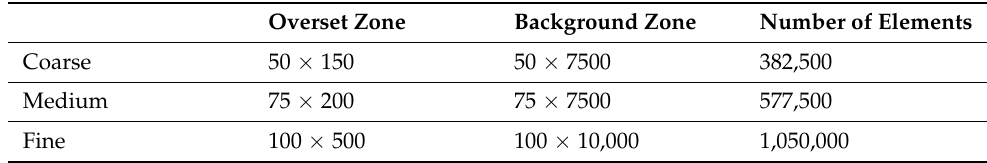
Figure 8. Pressure coefficient (cid:1829) (cid:3043) distribution at t = 1 s, M = 0.6, p = 10 kPa, (cid:2010) = 0.56 . Table 2. Grid